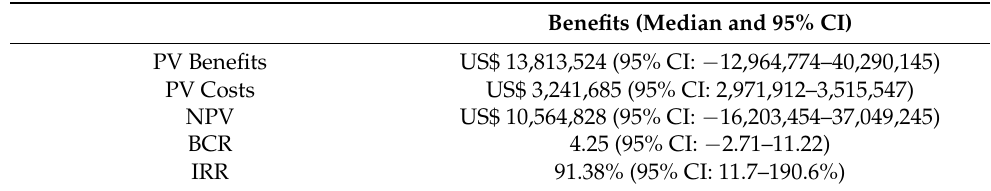
Table 3. Summary of a cost–benefit analysis of a mass vaccination program applied for twenty years to control brucellosis in small ruminants in Dohuk Governorate, Iraq.